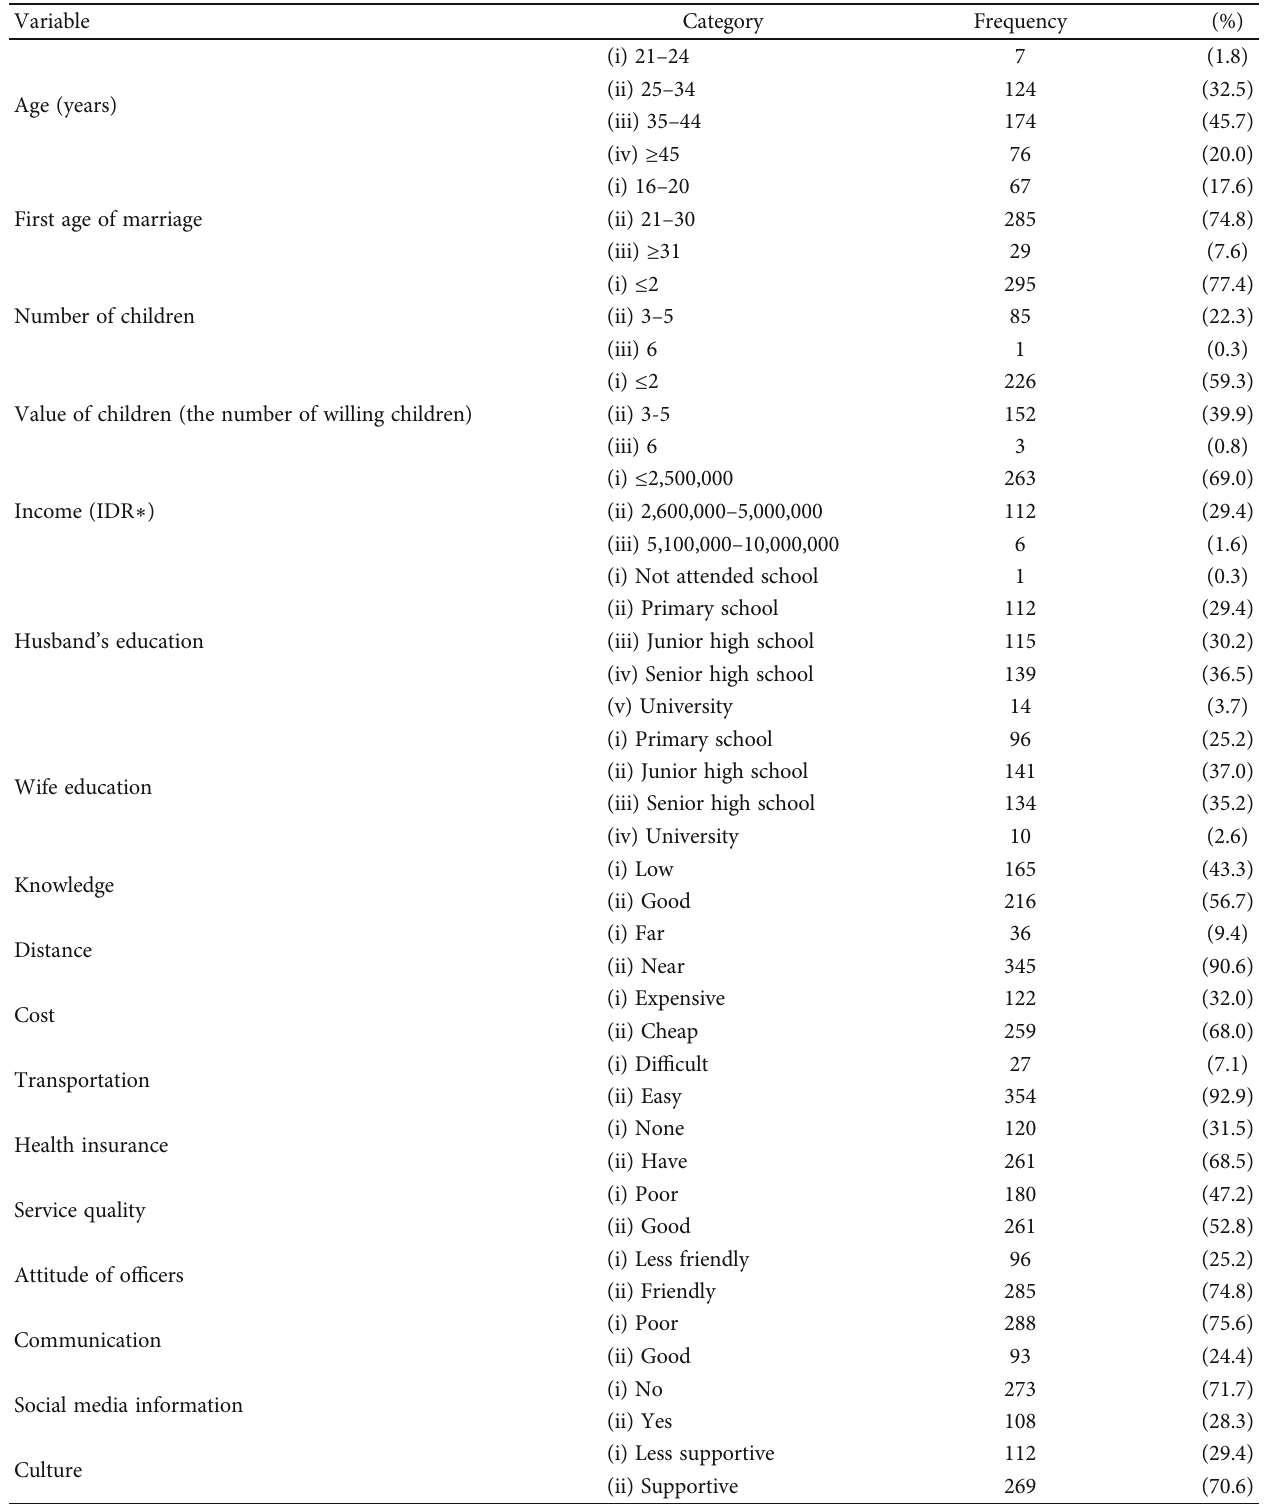
Table 1: Respondent characteristics and